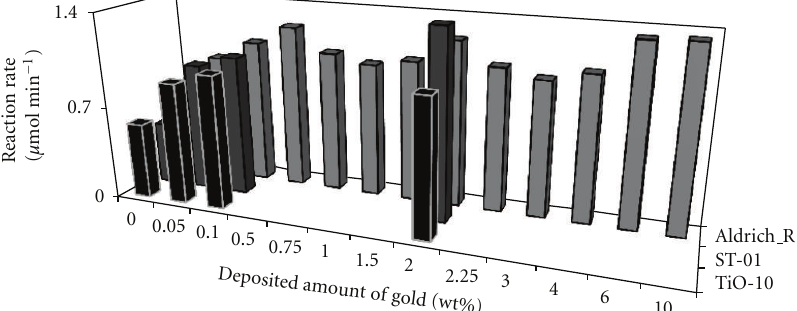
Figure 11: UV/vis photoactivity of gold modified titania photocatalysts: ST-01, TIO-10, and Aldrich R during acetic acid oxidation. 00.10.20.30.40.5